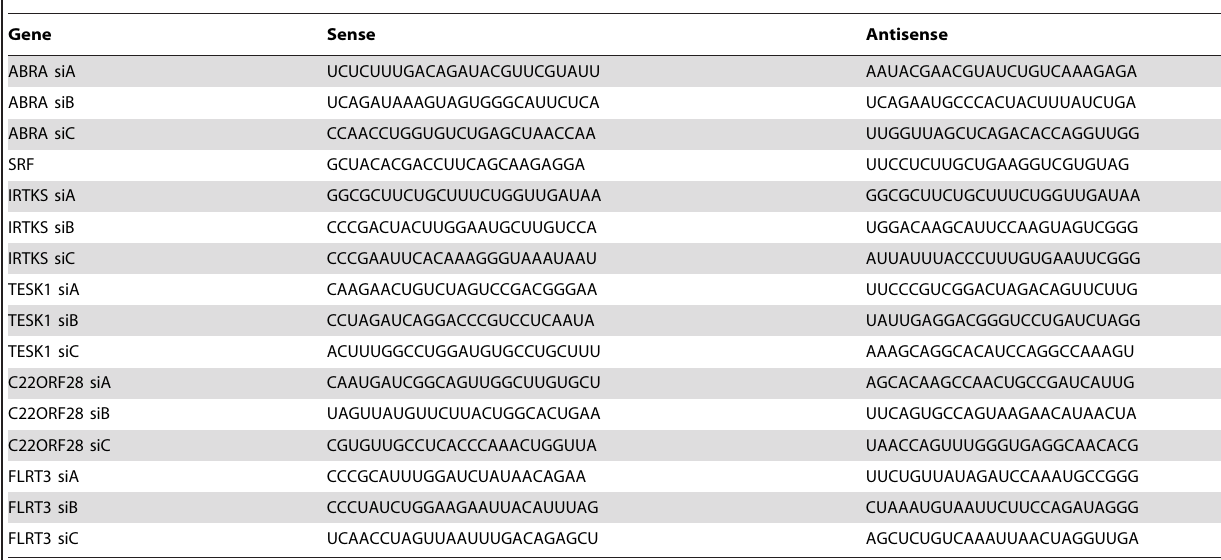
Table 2. siRNA silencing